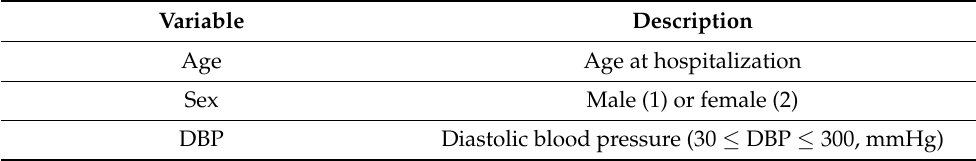
Table 2. Electronic health records (EHR) data